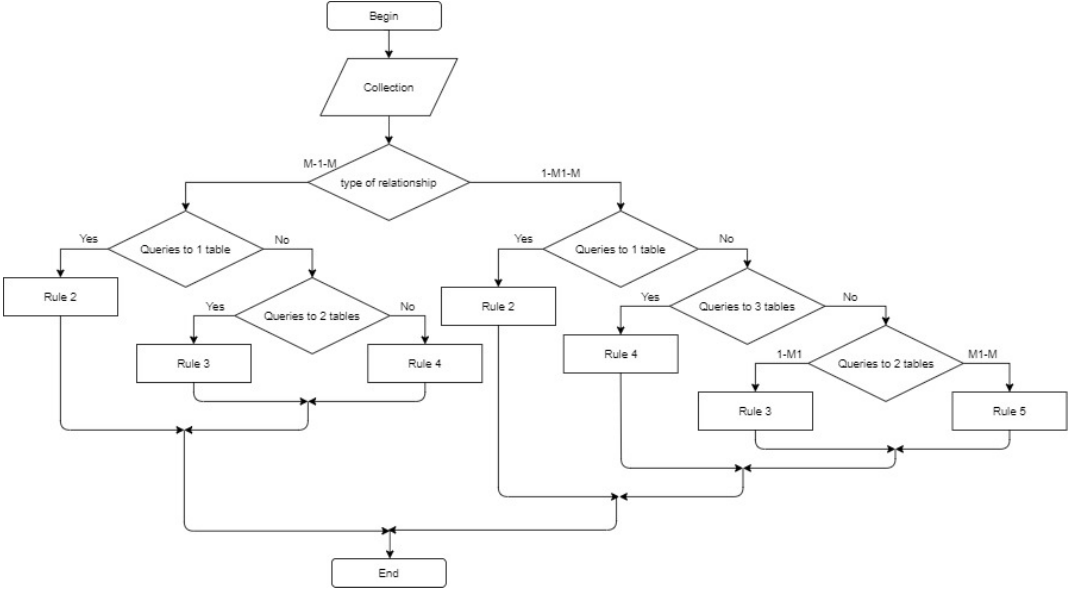
Figure A1. A diagram showing the execution time of six queries to a database of two types: a single database and a database with embedded documents.